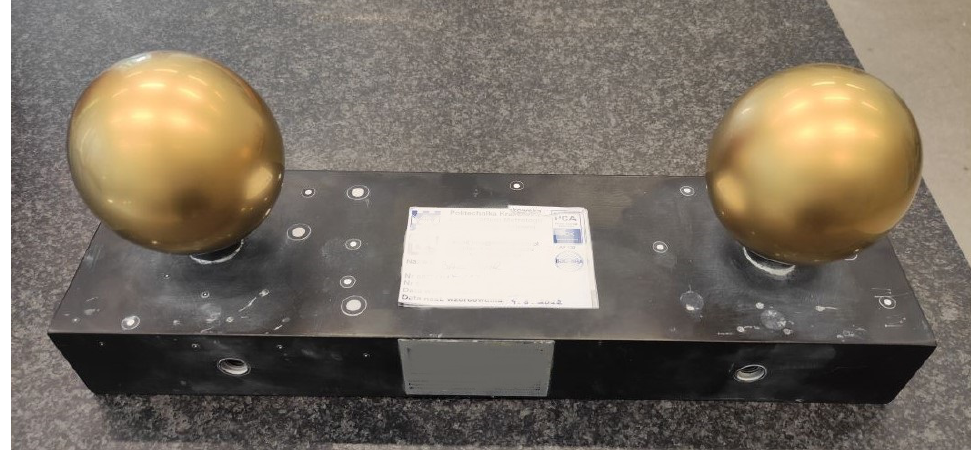
Figure 1. Calibration balls in the Laboratory of Coordinate Metrology, Cracow University of Technology. The set consisted of two polished and tarnished metal balls d 1 and d 2 . Their diameters were d 1 = 85.02 mm and d 2 = 85.01 mm respectively, with a shape deviation of δ k = 0.02 mm. The spheres were placed on a metal frame at a distance of d k = 269.4 mm. The listed values have been confirmed on a calibration certificate by an accredited laboratory. The measurement set allowed for the precise verification of the quality of the spatial representation of the